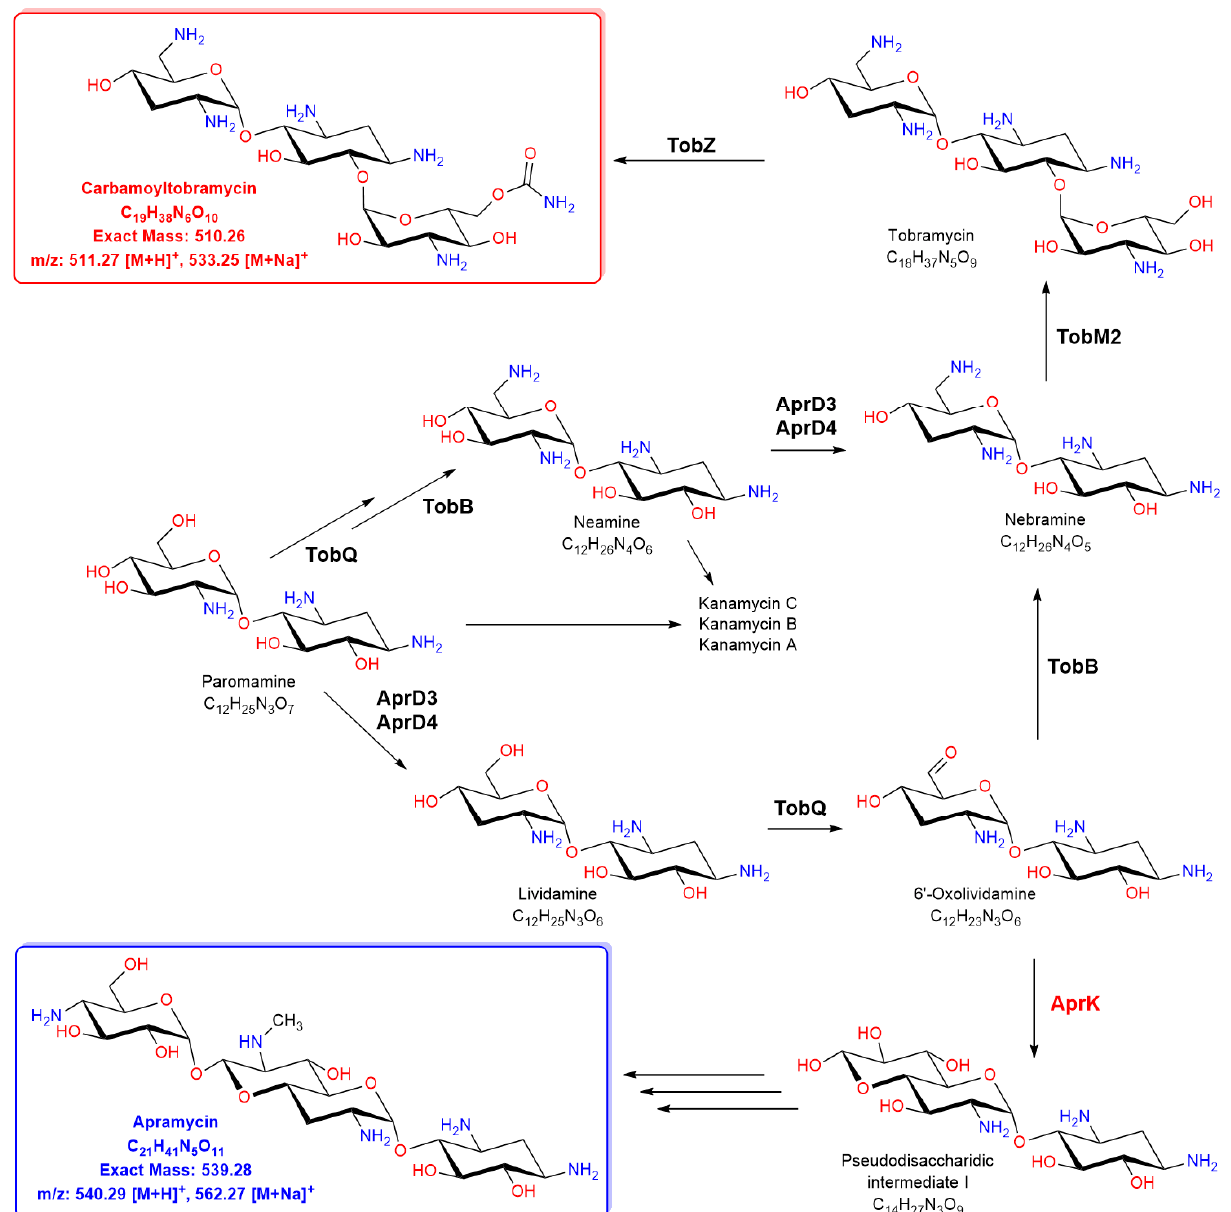
Figure 1. Proposed biosynthetic pathways for carbamoyltobramycin and apramycin (modified from Lv et al. [9] and Xiao et al. [10]). The biosynthesis starts with paromamine, which is the key branch point intermediate in aminoglycoside biosynthesis in Streptoalloteichus tenebrarius.